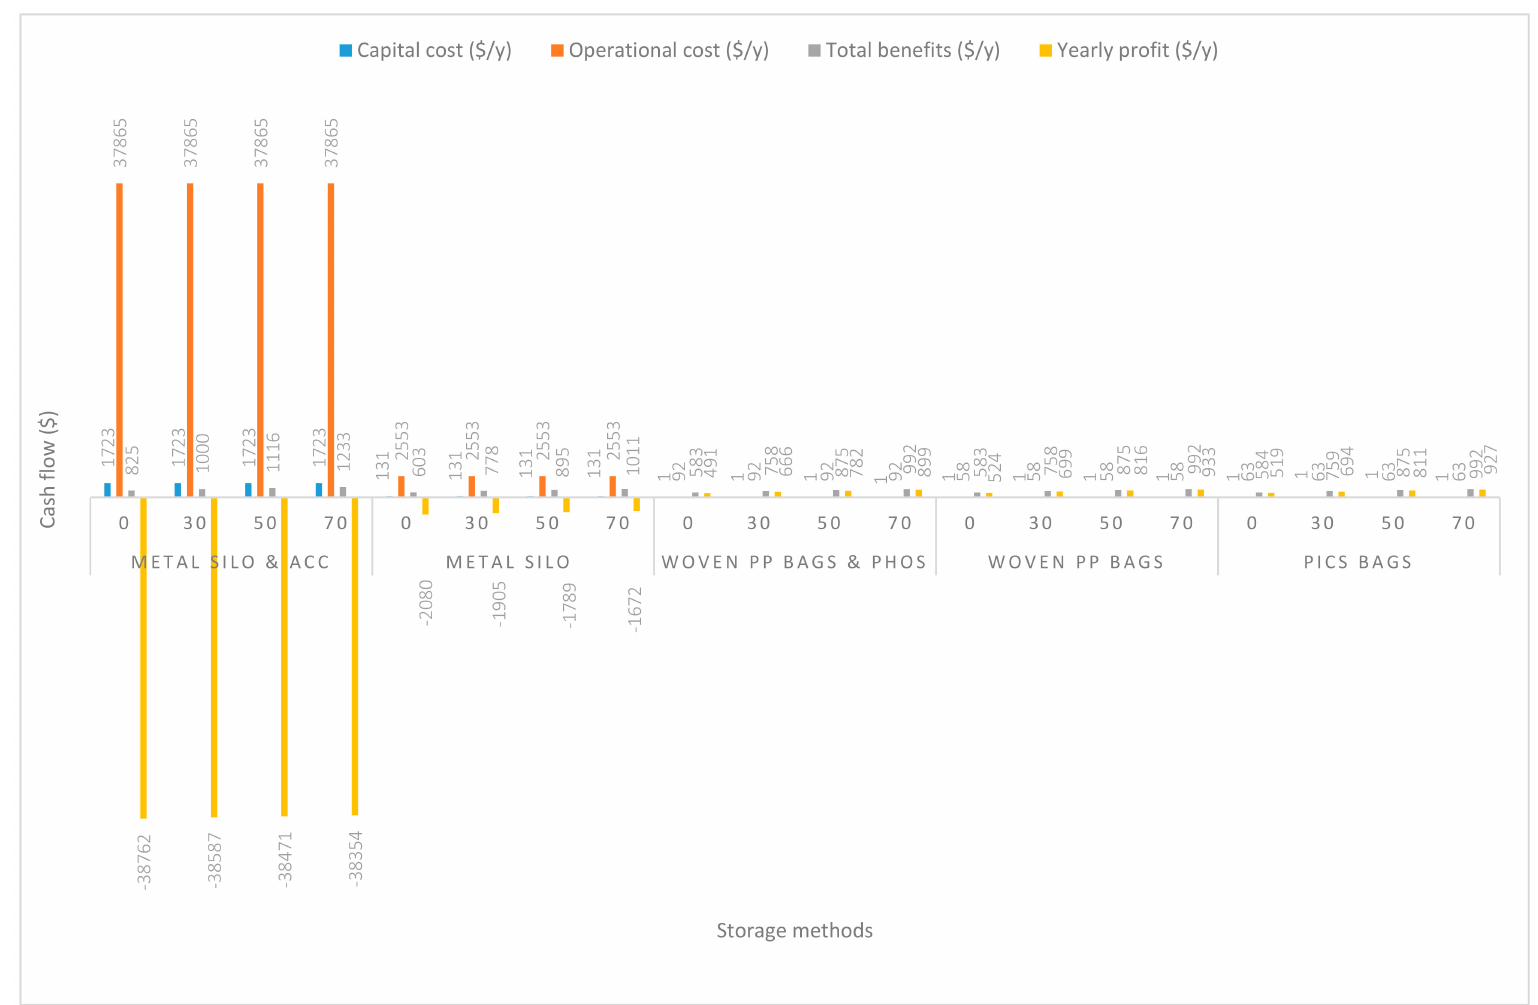
Figure 2. Annual capital and operational costs (US dollars), total annual benefits, and profits (US dollars) for each handling / storage method at 2.8 Mg / y handling capacity for 0%, 30%, 50%, and 70% grain price